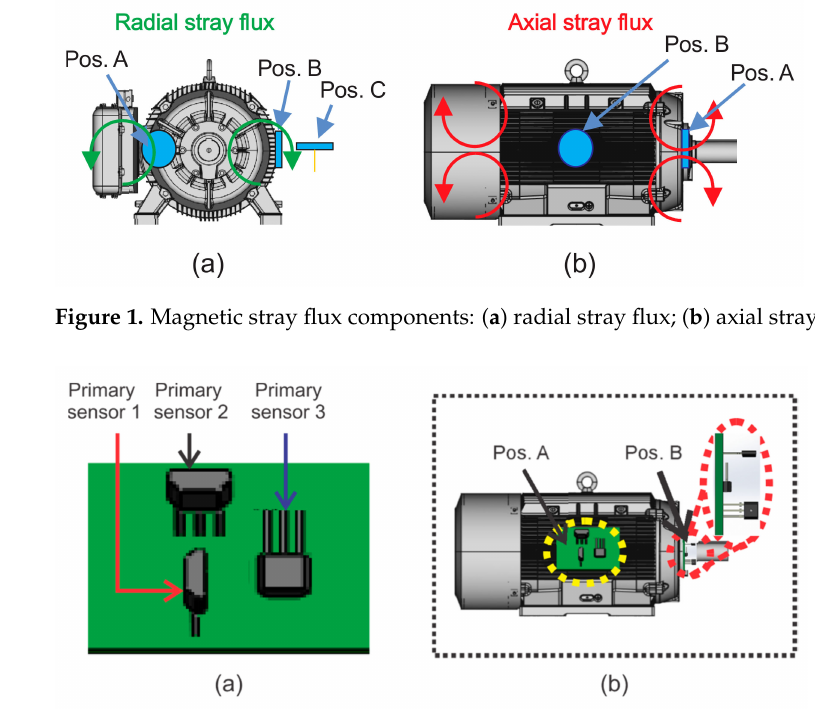
Figure 2. Triaxial stray flux architecture: ( a ) primary sensors; ( b ) axial stray flux